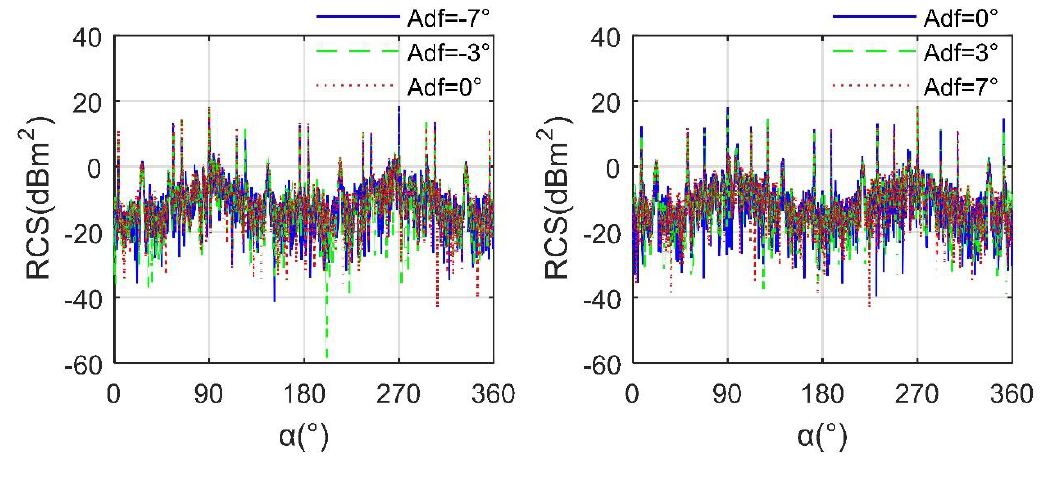
( a ) RCS curve at t = 3.611 × 10 − 3 s. (b) RCS curve at t = 1.361 × 10 −2 s. Figure 12. RCS of helicopter at various A dr , f RH = 10 GHz, n r1 = n r2 = 1200 r/min, β = 0°, A dr = 0°, γ = θ = 0°.